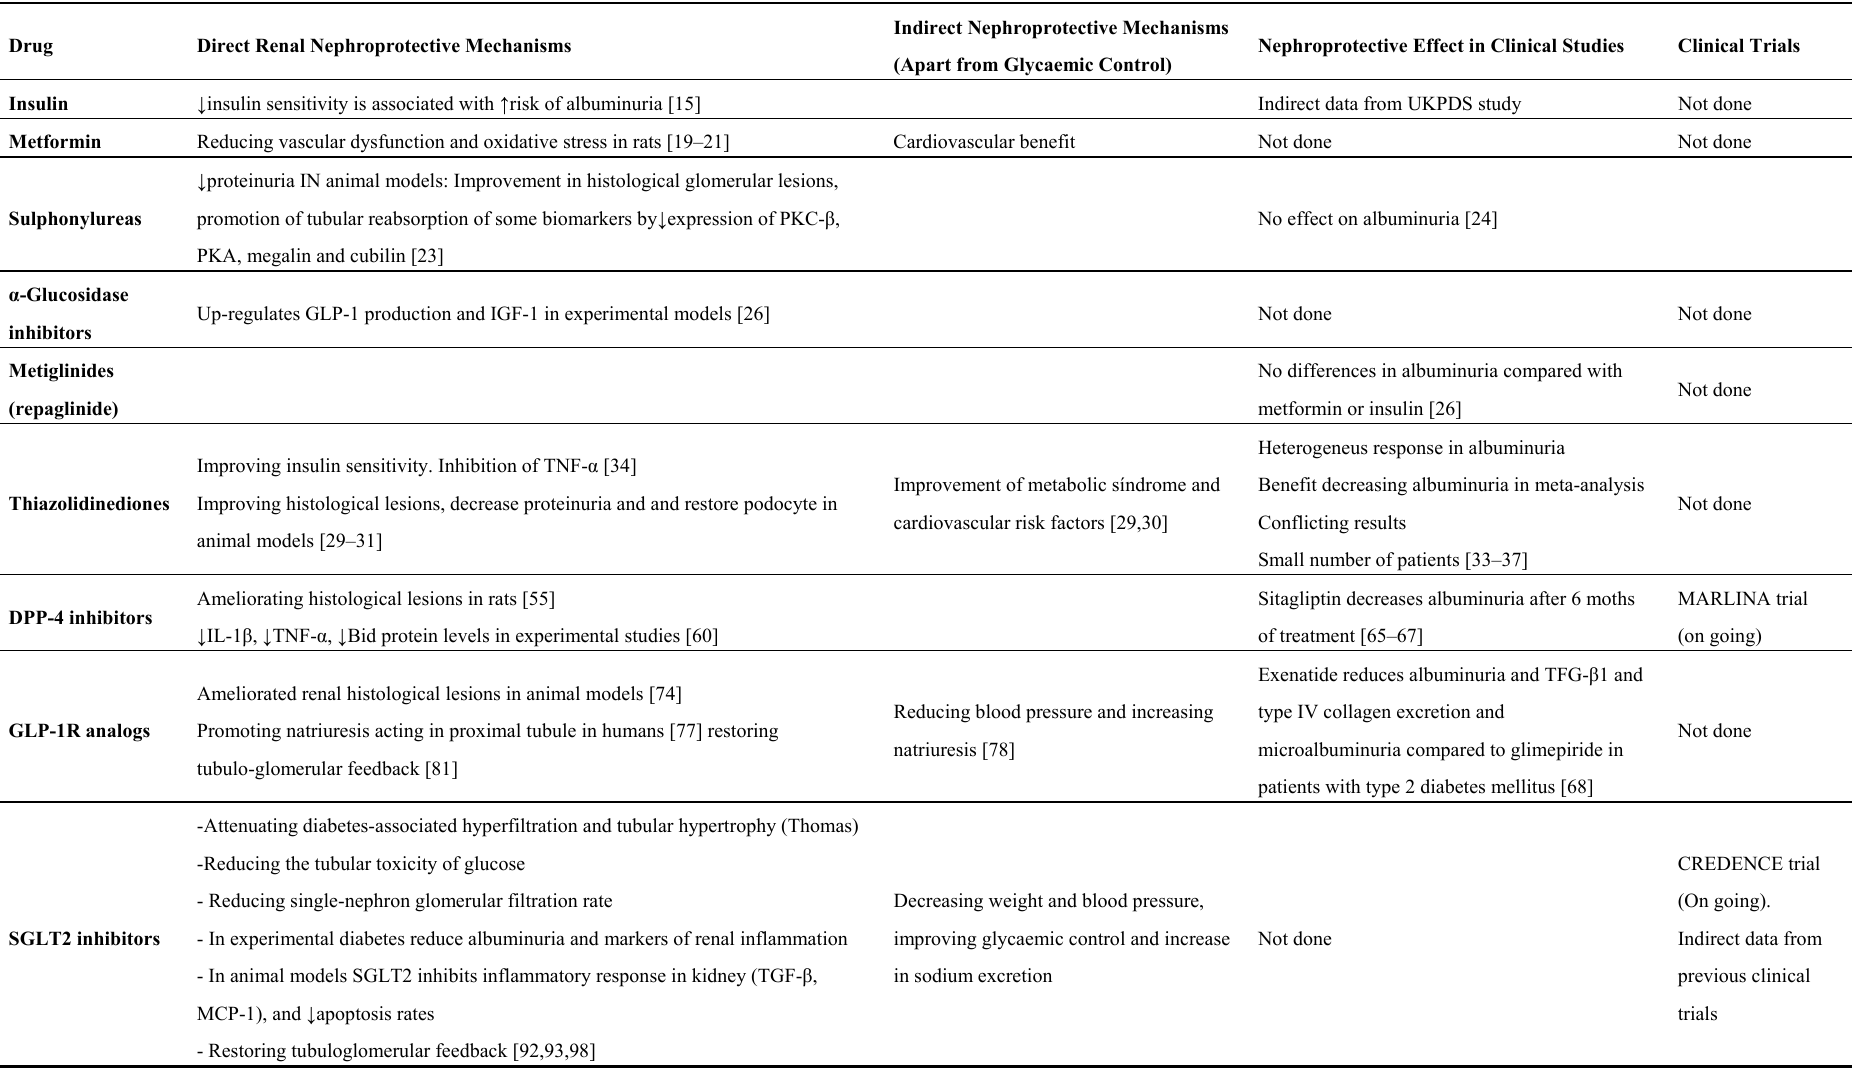
Table 1. Summary of renal effects of hypoglycemic drugs on nephroprotection: experimental and clinical